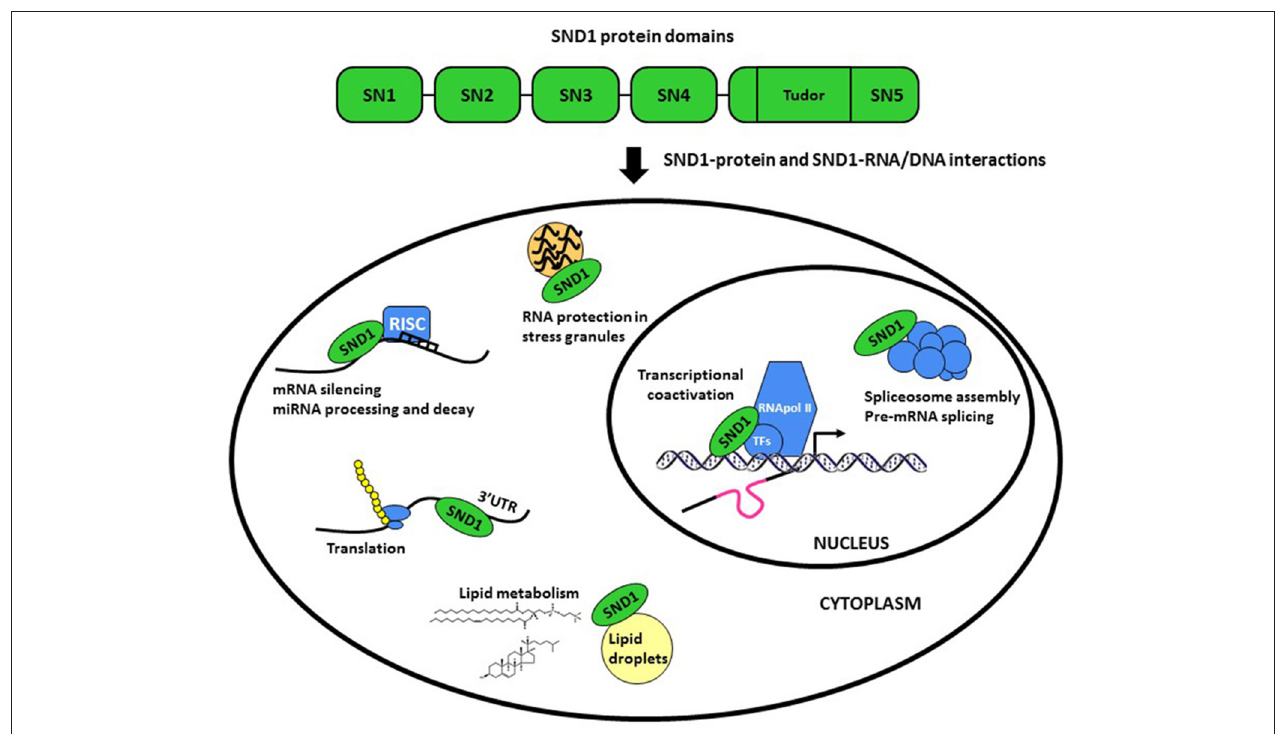
FIGURE 1 | Schematic representation of the structure and functions of SND1 protein. The protein comprises a tandem of four Staphylococcal nuclease-like domains (SN1-4) followed by a fusion of an entire Tudor domain and a truncated SN domain (SN5). SN and Tudor domains enable SND1 for interacting with RNA/DNA and proteins to operate in a plethora of